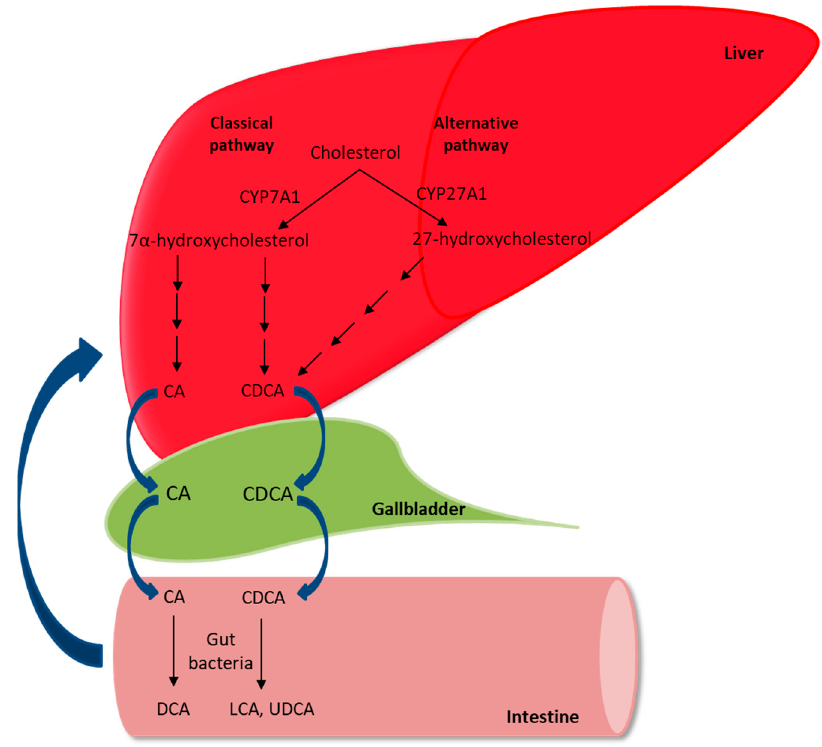
Figure 1. A simplified view of bile acid metabolism in humans. CYP7A1, cholesterol 7 α -hydroxylase; CYP27A1, sterol-27 hydroxylase; CA, cholic acid; CDCA, chenodeoxycholic acid; MCA, muricholic acid; DCA, deoxycholic acid; LCA, lithocholic acid; and UDCA, ursodeoxycholic